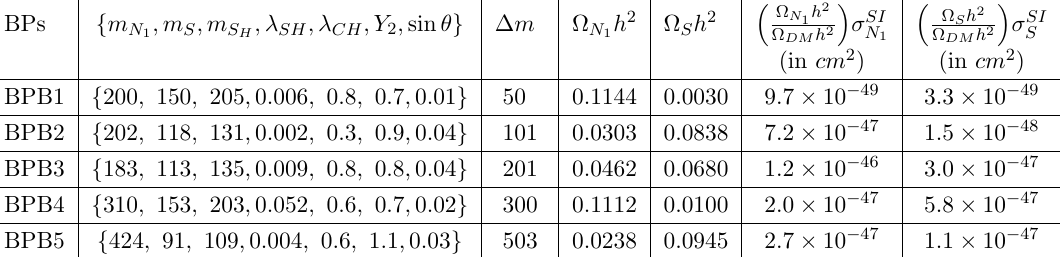
Table 3 . Benchmark points allowed by relic density, direct search and invisible Higgs decay limit in presence of a heavy scalar S H . Input parameters (masses and couplings), relic densities of individual components and direct search cross-sections are mentioned. All the masses are in